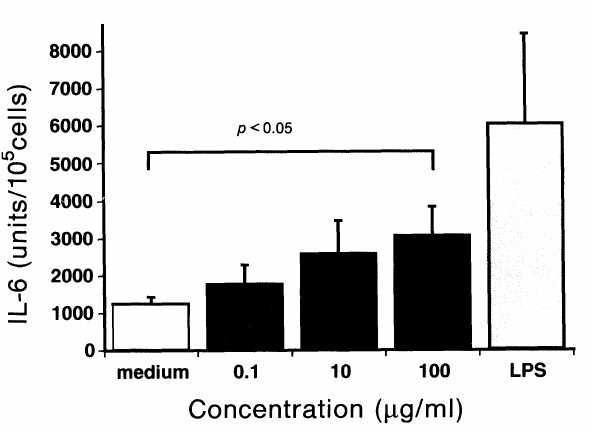
FIG. 2. Effect of increasing concentrations of human dimeric IgA on the production of IL-6 by MC in vitro. MC were incubated in triplicate with IgA for 72 h. After incubation the supernatants were assessed for IL-6. The effect of LPS, as a positive control, is also shown on the right.